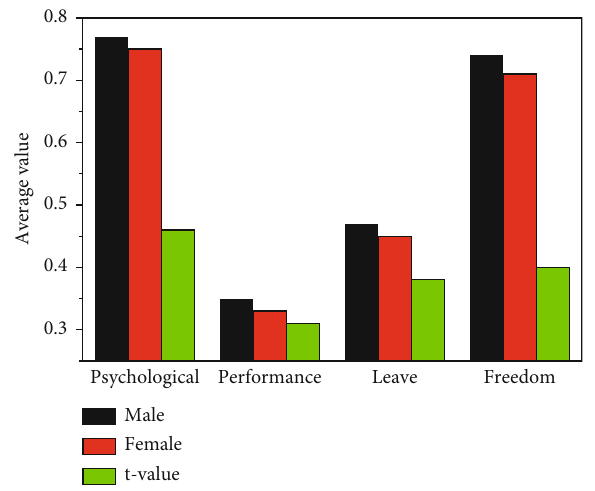
Figure 3: Variance analysis of gender-speci fi c